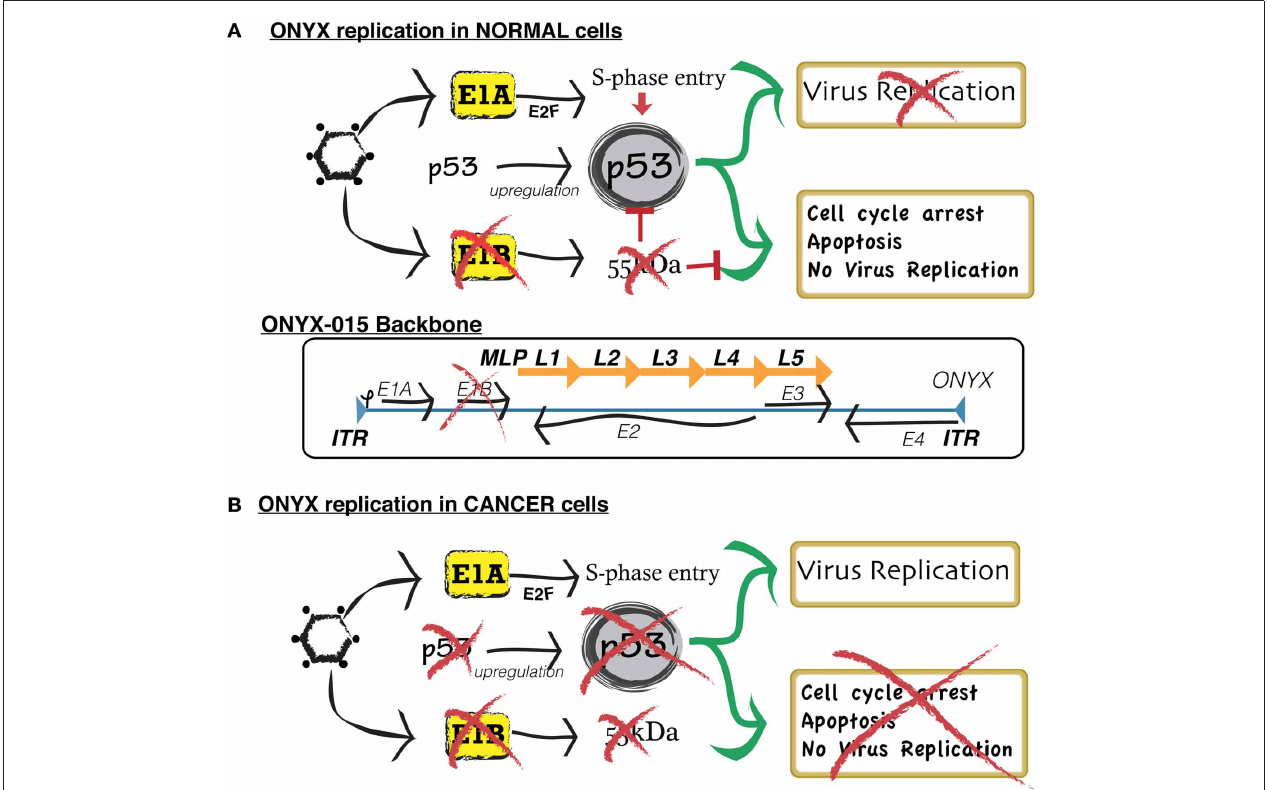
FIGURE 2 | Simplified scheme comparing the mechanism of replication of conditionally replicative ONYX in normal cells and neoplastic cells. (A) In normal cells, wild type adenoviruses replicate by blocking the normal activity of p53, a gene that, by inducing cell apoptosis, defends the host cell from viral infection. In order to exploit such function for targeted cancer therapy, researchers developed ONYX-015. ONYX-015 is a genetically engineered oncolytic adenovirus